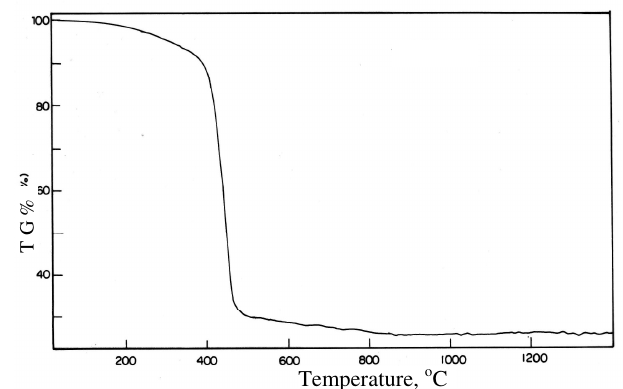
Figure 4. TGA thermogram of nylon-66